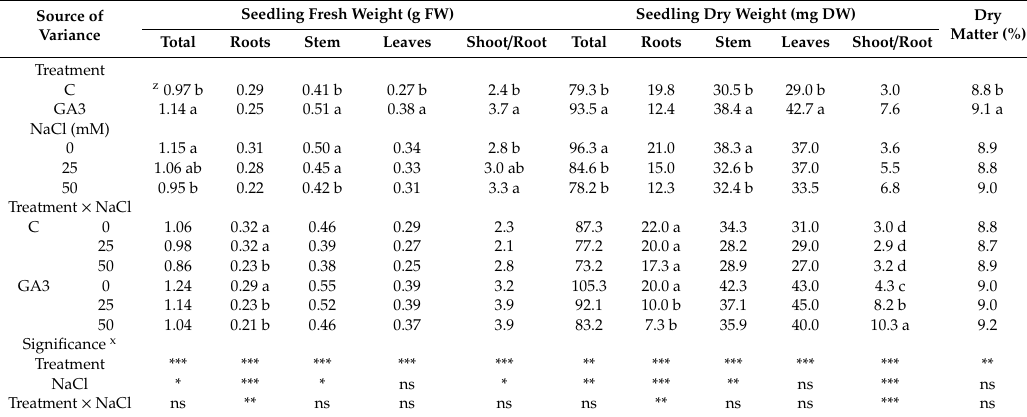
Table 3. E ff ects of the gibberellic acid treatment (C, not treated; GA3, GA 3 -treated seedlings) and salt stress (0, 25, and 50 mM NaCl in the irrigation water) on morphological parameters of sweet pepper seedlings.